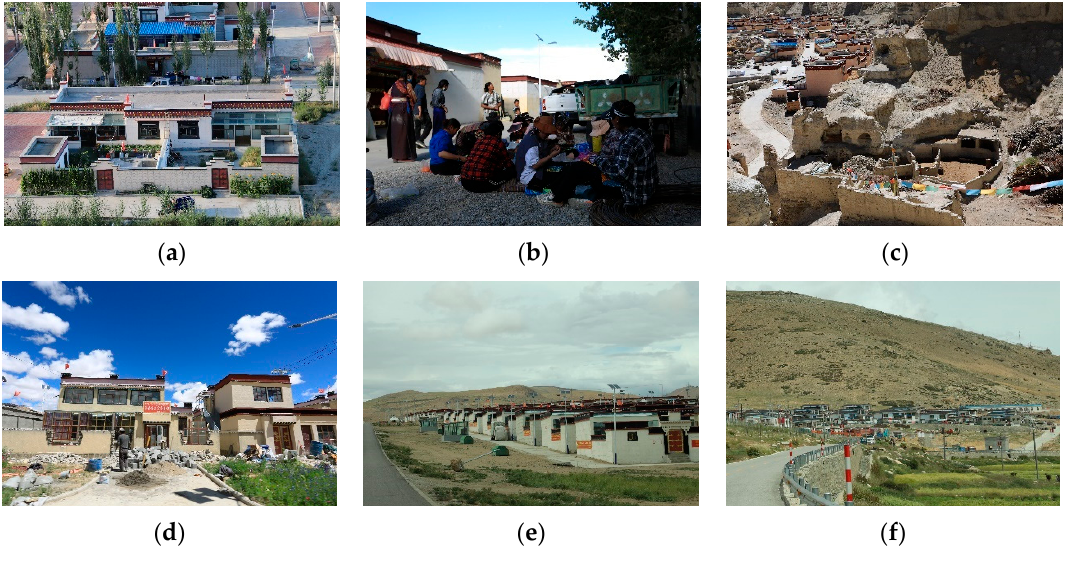
Figure 2. The construction of rural settlements in Himalaya (self-photographed): ( a ) the house-yard of Zhaburang; ( b ) women in Boling weaving temple supplies in yards; ( c ) old buildings turned into cowsheds in Rebugalin; ( d ) the Tibetan homestay inn in Qulong; ( e ) photovoltaic wells along the road; ( f ) motorized barley harvesting.